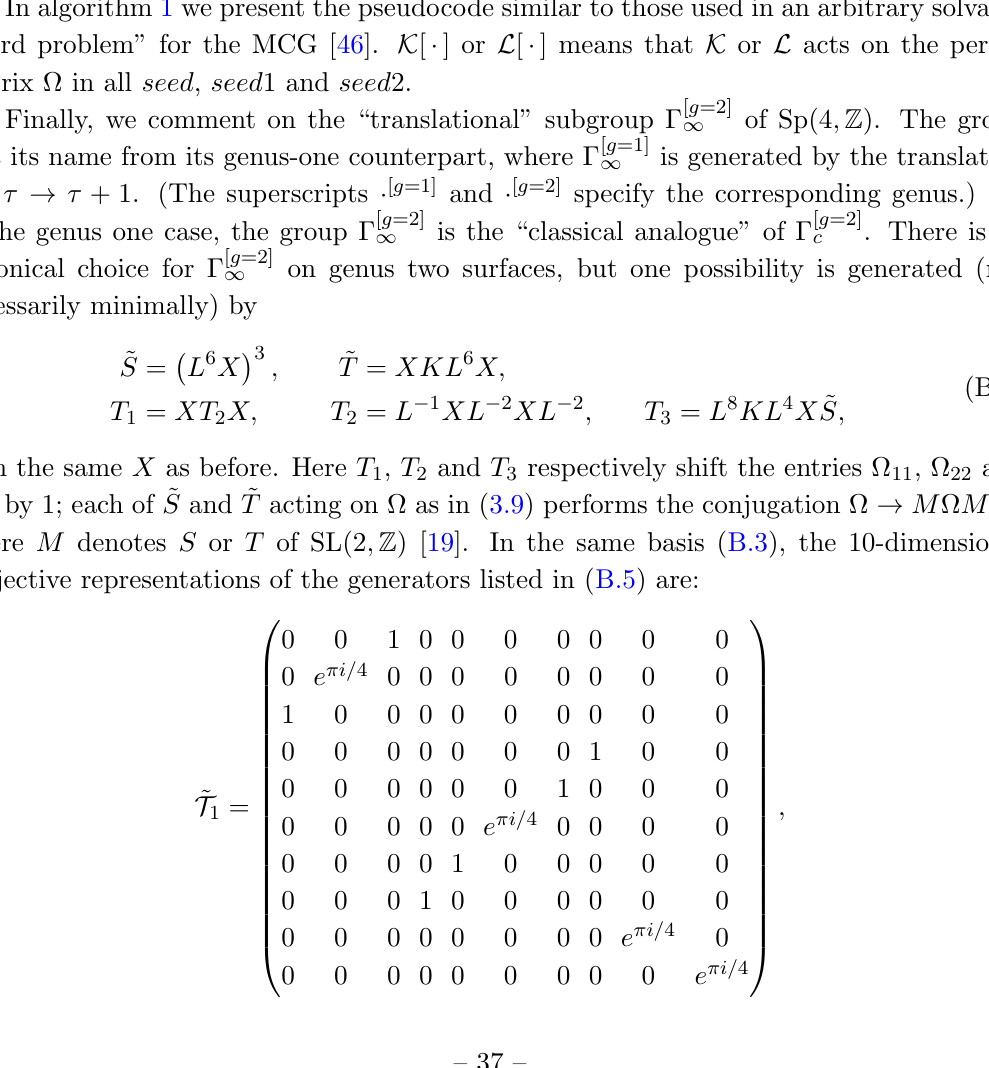
Algorithm 1. The pseudocode used to compute the index of the subgroup (cid:0) c in the MCG (cid:0) g for g =